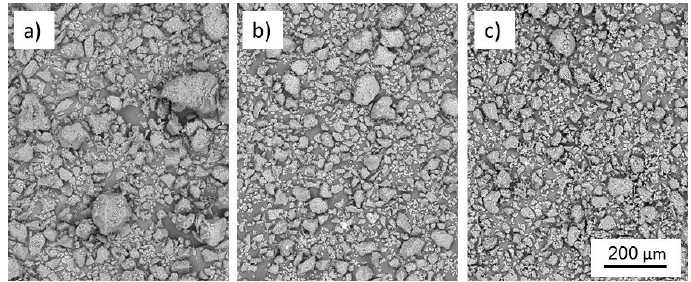
Figure 1. SEM micrographs of organosolv particles prior to ( a ) and after thermostabilisation ( b ) and carbonisation, respectively ( c ).